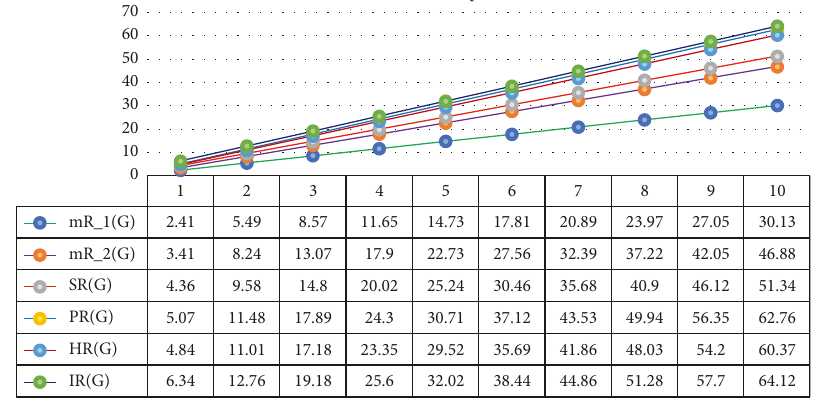
Figure 4: Comparison of m R